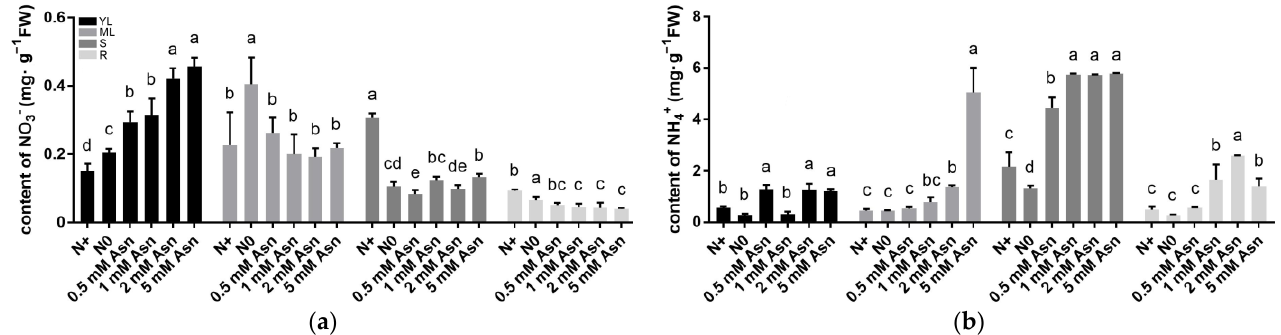
Figure 2. The contents of nitrate ( a ) and ammonia ( b ) in various tissues of the poplar ‘Nanlin895’ under different asparagine (Asn) treatments. “N0” indicates N-free; “N+” represents the inorganic N control. The concentration of Asn applied was 0.5 mM, 1 mM, 2 mM, or 5 mM, as indicated. YL, young leaves; ML, mature leaves; S, stems; R, roots. Bars indicate means ± SD (n ≥ 3), and different letters indicate significant differences ( p < 0.05) based on Duncan’s test.